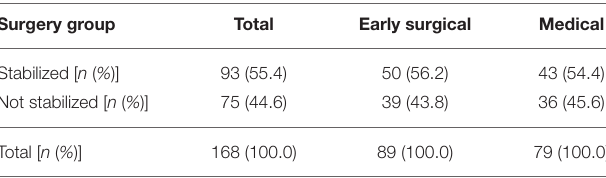
TABLE 4 | Contingency table for stabilization between “early surgical” ( n = 89) and “medical” ( n = 79). Surgery group Total Early surgical